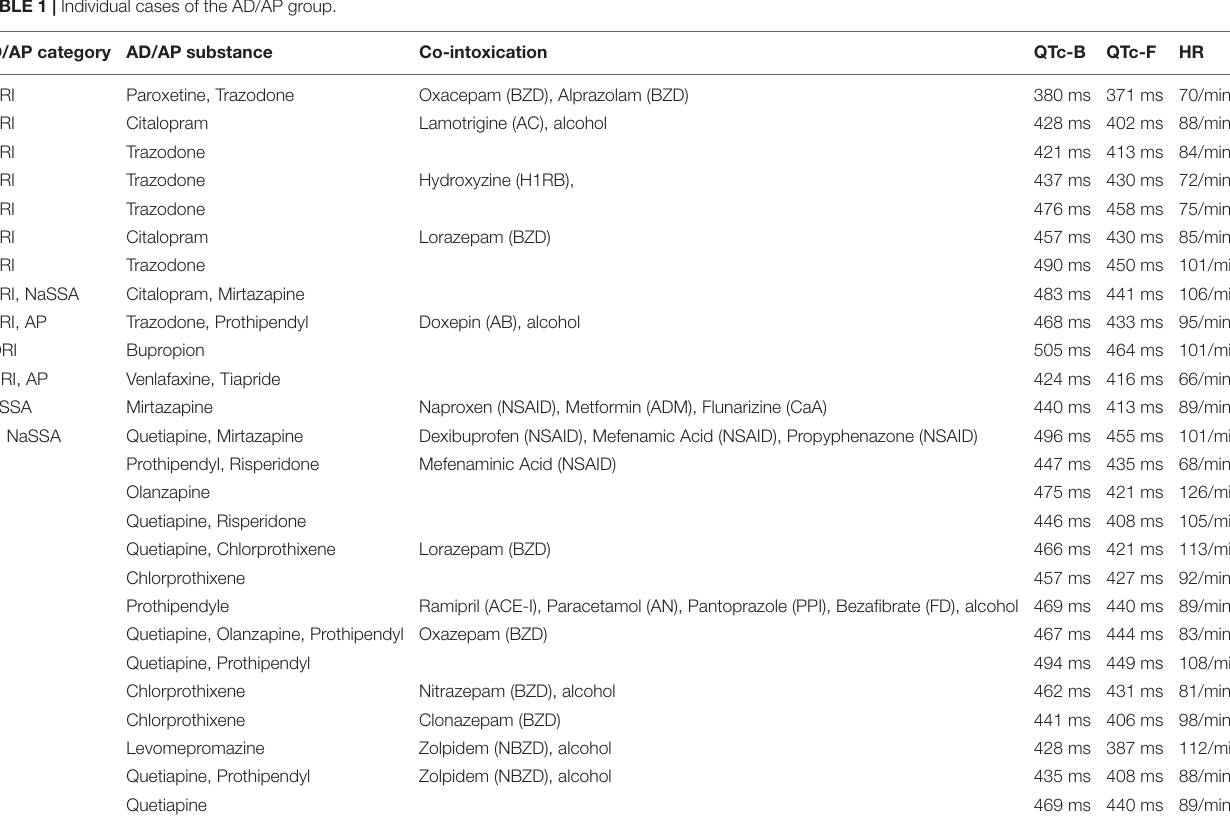
TABLE 1 | Individual cases of the AD/AP